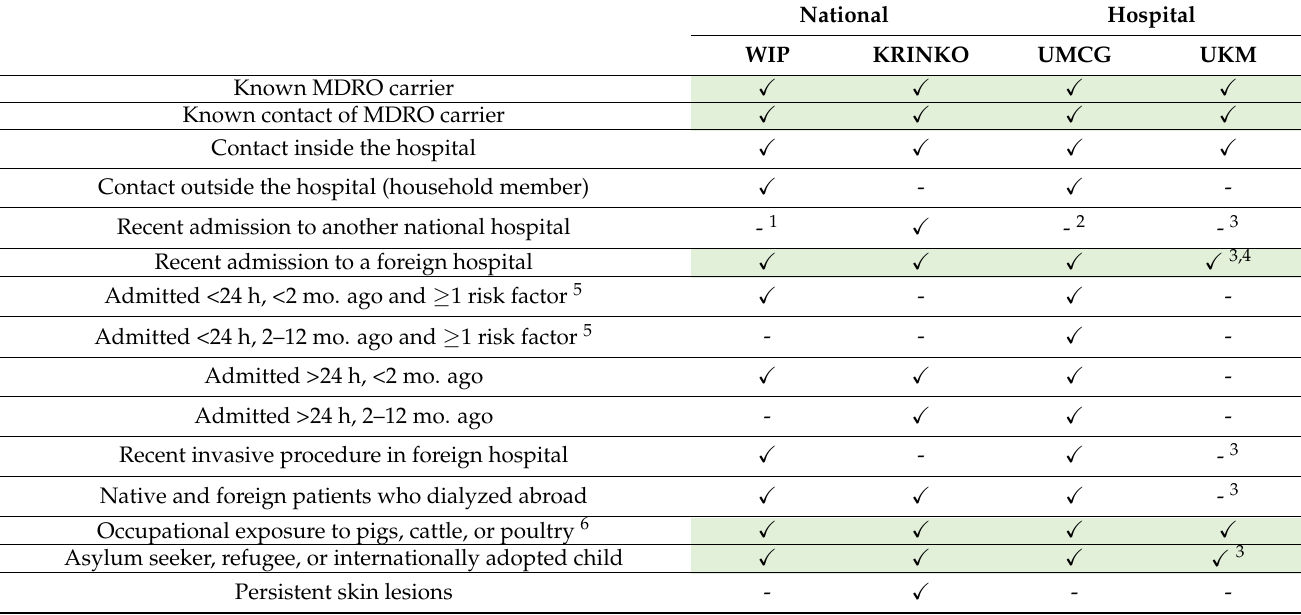
Table 1. Overview of MDRO risk factors and screening criteria